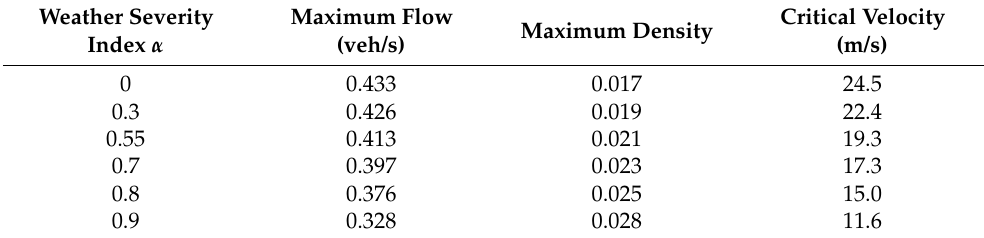
Table 4. Maximum flow and density, and critical velocity for the proposed model.